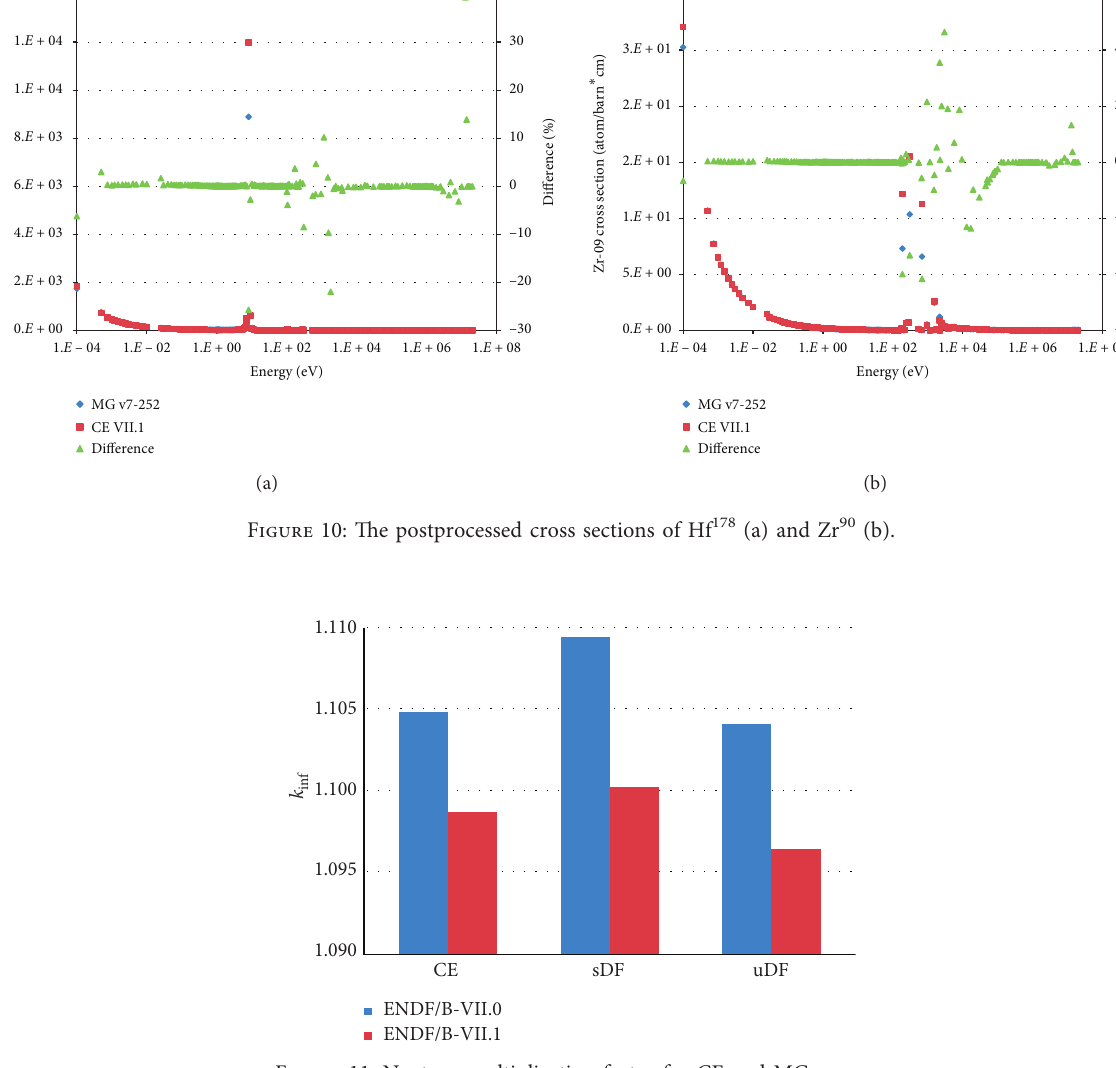
Figure 11: Neutron multiplication factor for CE and MG